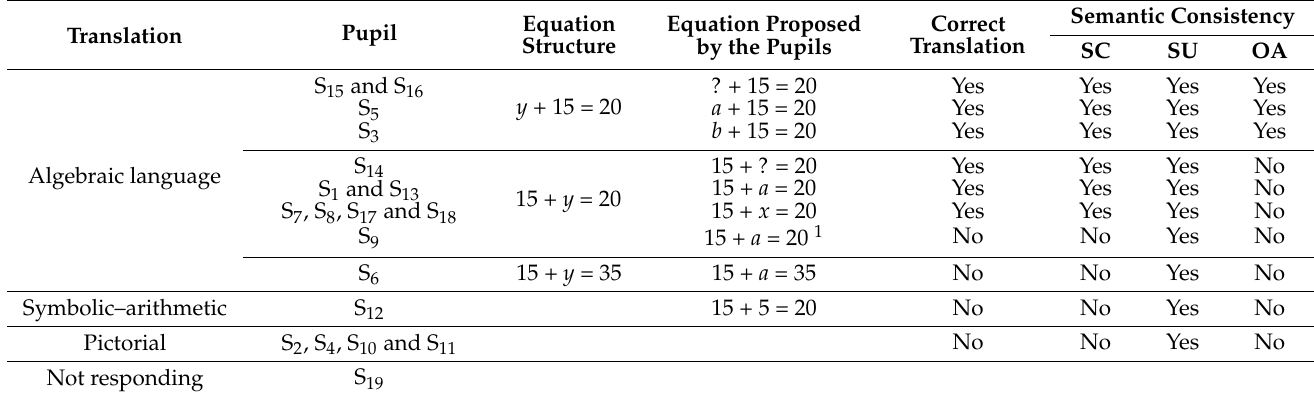
Table 1. Equations proposed by the pupils in the pencil problem (structure y + 15 =